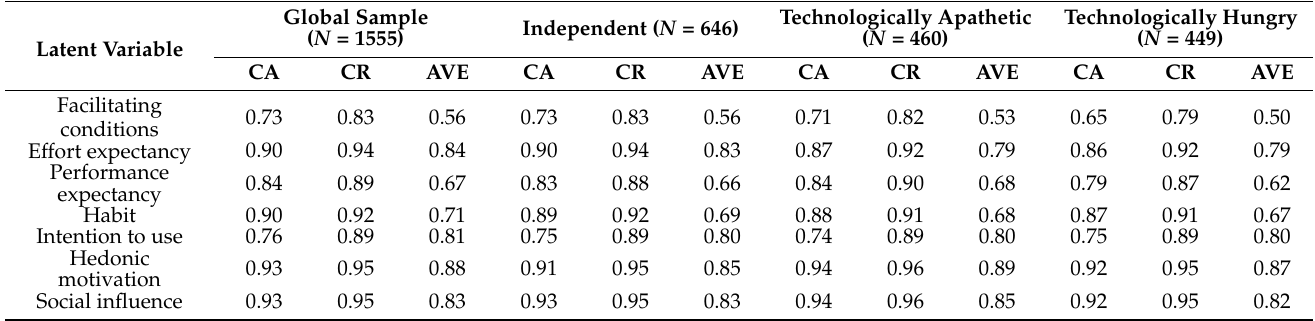
Table 3. Cronbach’s alpha, composite reliability, and average variance